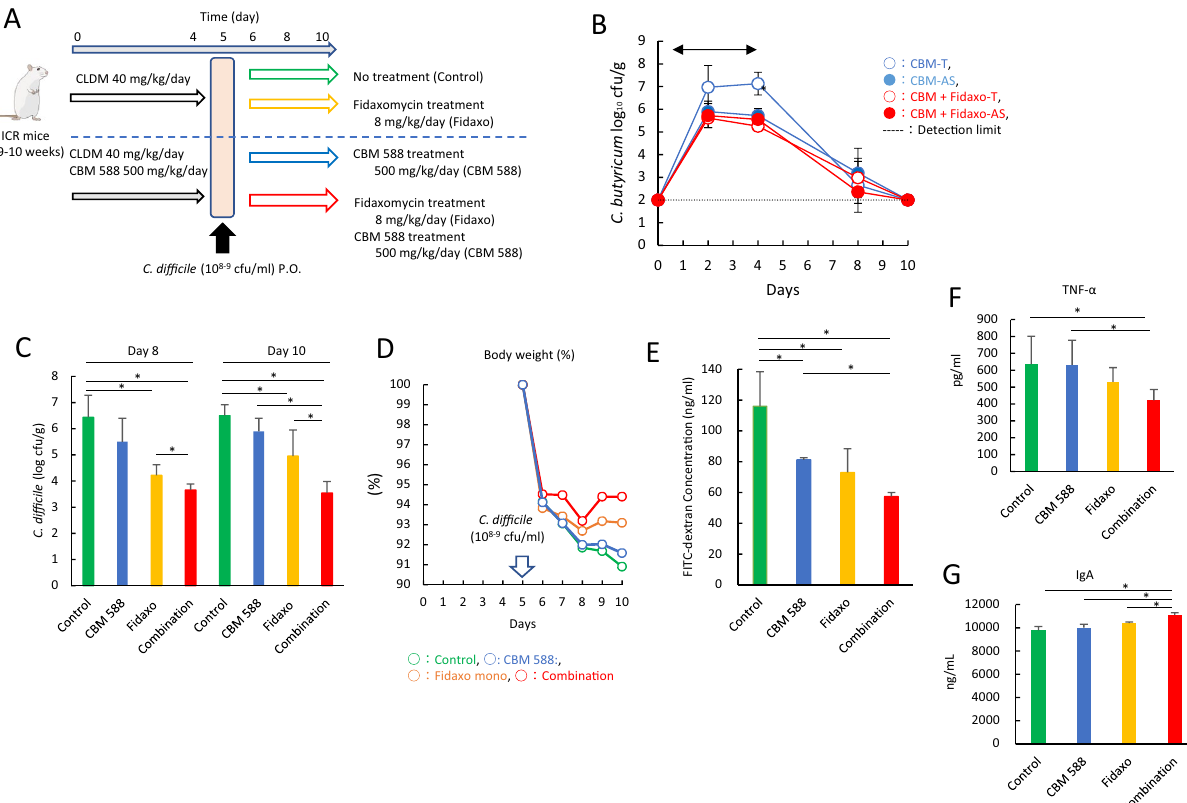
Figure 1. C. butyricum enhanced C. difficile colonization resistance in the gut and attenuated gut inflammation when used with an anti- C. difficile antibiotic agent. ( A ) Experimental design of the Clostridioides difficile infection model with 9- to 10-week-old ICR Swiss mice. ( B ) Enumerating C. butyricum in feces. (open circle): total colony count in CBM 588 administration group (CBM 588-T), (filled circle): spore colony count in CBM 588 monotherapy group (CBM 588-AS), (open circle): total colony count in combination group (Combination-T), (filled circle): spore colony count in combination group (Combination-AS). The testing detectable level is above 2.0 (log amount) per gram of feces, data shown as mean ± SD (n = 5–10 per group). ( C ) Enumerating C. difficile in feces at day 8 and 10. 1: control group (Control), 2: CBM 588 monotherapy group (CBM 588), 3: fidaxomicin monotherapy group (Fidaxo), and 4: combination (CBM 588 + fidaxomicin) group (Combination). The testing detectable level is above 2.0 (log amount) per gram of feces, data shown as mean ± SD (n = 5–10 per group). ( D ) Weight changes of control group (green), CBM 588 administration group (blue), fidaxomicin administration group (yellow), and combination group (red) over the duration of the study (from C. difficile inoculation to day 10), data shown as mean (n = 5 per group). ( E ) Intestinal permeability was determined. All values are mean ± SD (n = 5). ( F ) Tumor necrosis factor-α (TNF-α) and ( G ) Immunoglobulin A (IgA) protein concentrations in mice colon tissue detected at day 8. All values are mean ± SD (n =